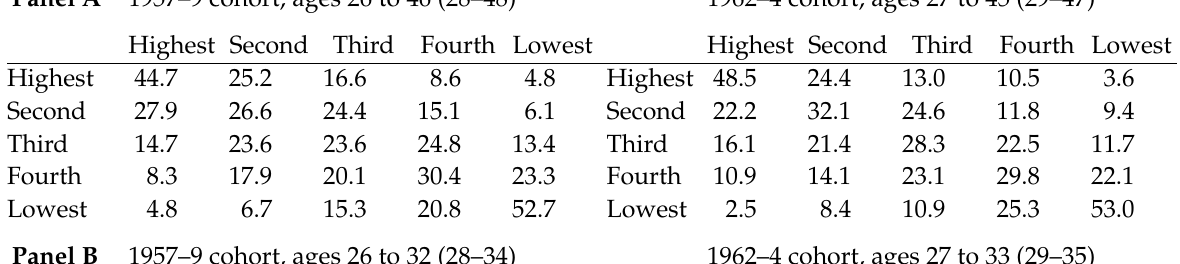
Table 1: Transition Matrices, Income Quintiles Panel